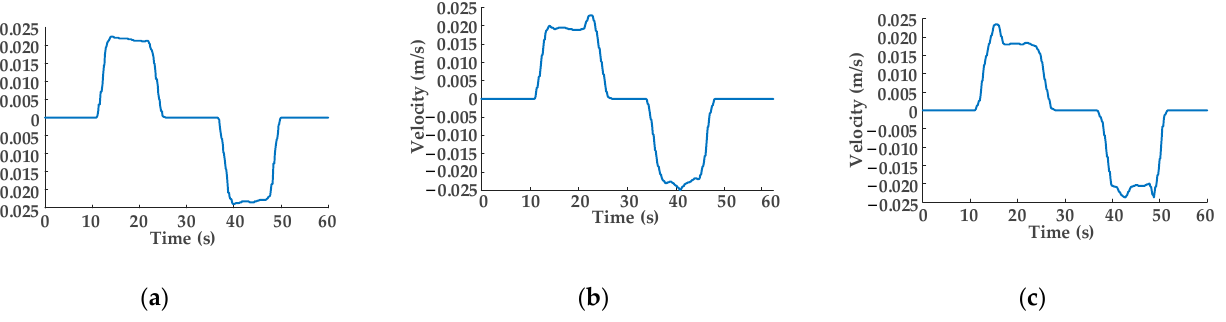
Figure 10. Speed variation curves of the hydraulic cylinder piston rod: ( a ) output pressure of the constant-pressure variable pump is 7 MPa; ( b ) output pressure of the constant-pressure variable pump is 6 MPa; ( c ) output pressure of the constant-pressure variable pump is 5 MPa.